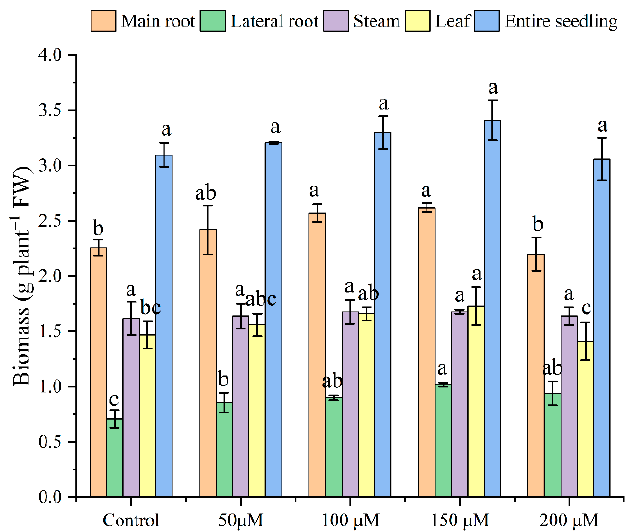
Figure 1. Effects of exogenous melatonin on tea seedling biomass under Cd stress. The data represent means ± standard deviations for three replicates. Different letters indicate groups that are significantly different at p < 0.05.